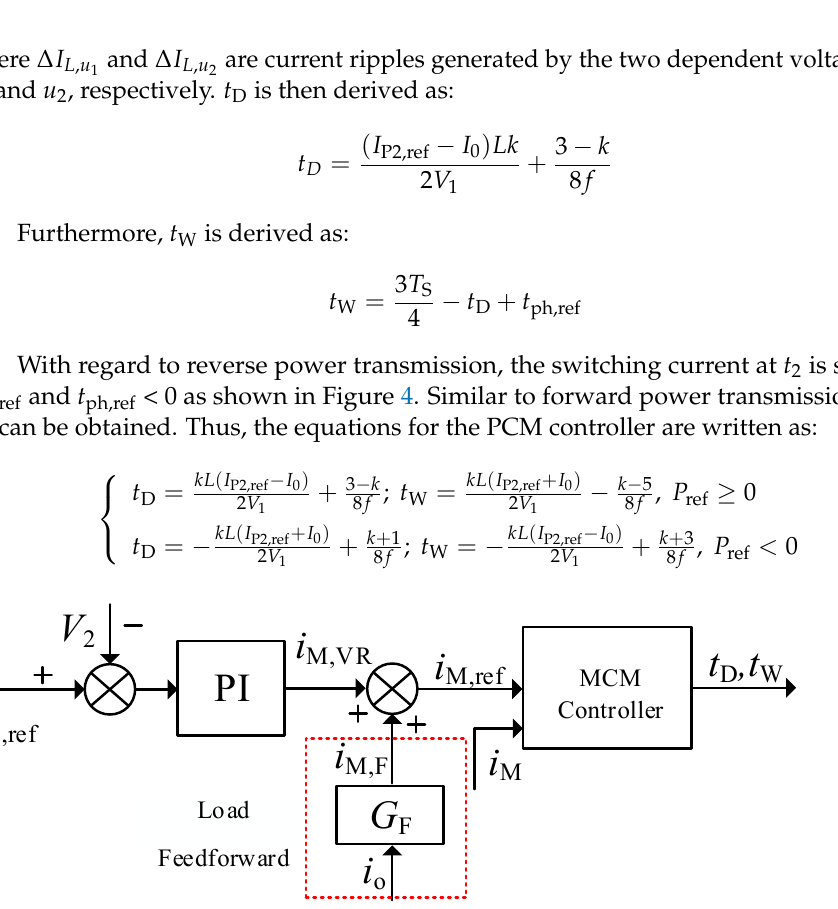
Figure 4. Voltage control scheme based on the MCM-ESPS controller.